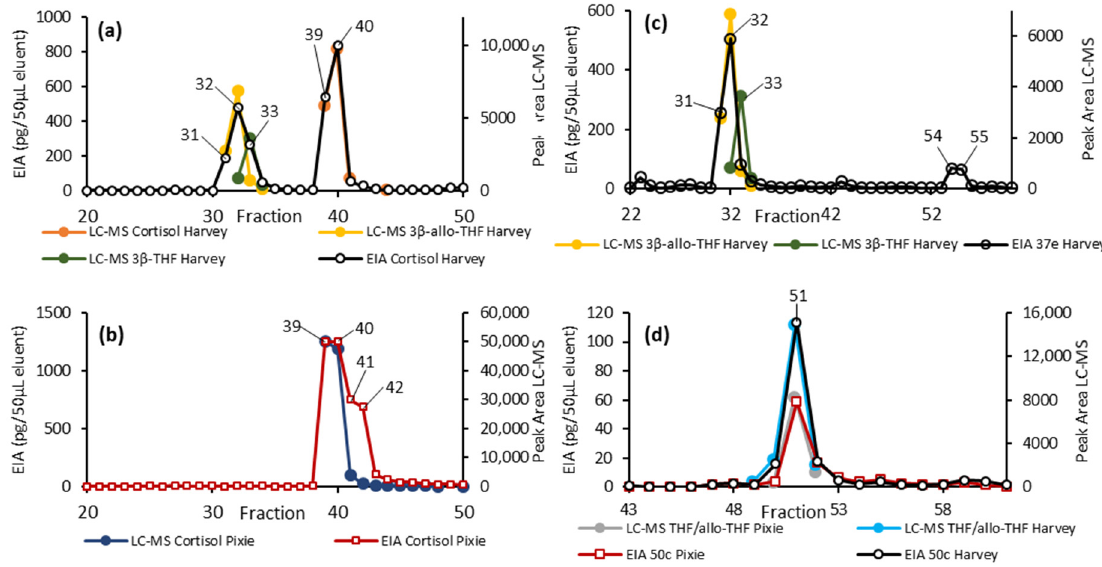
Figure 4. HPLC fractionation of the pooled AC samples from Harvey and Pixie. Here, we overlaid the detection by EIA (primary y -axis) and targeted LC-MS (secondary y -axis). ( a , b ) show the results from the cortisol EIA together with the LC-MS peak areas for the relevant metabolites for Harvey and Pixie, respectively. ( c ) shows the results of the 37e EIA for Harvey together with the LC-MS peak areas for 3 β -allo-THF and 3 β -THF. ( d ) overlays the results from the 50c EIA and LC-MS peak area for THF for both